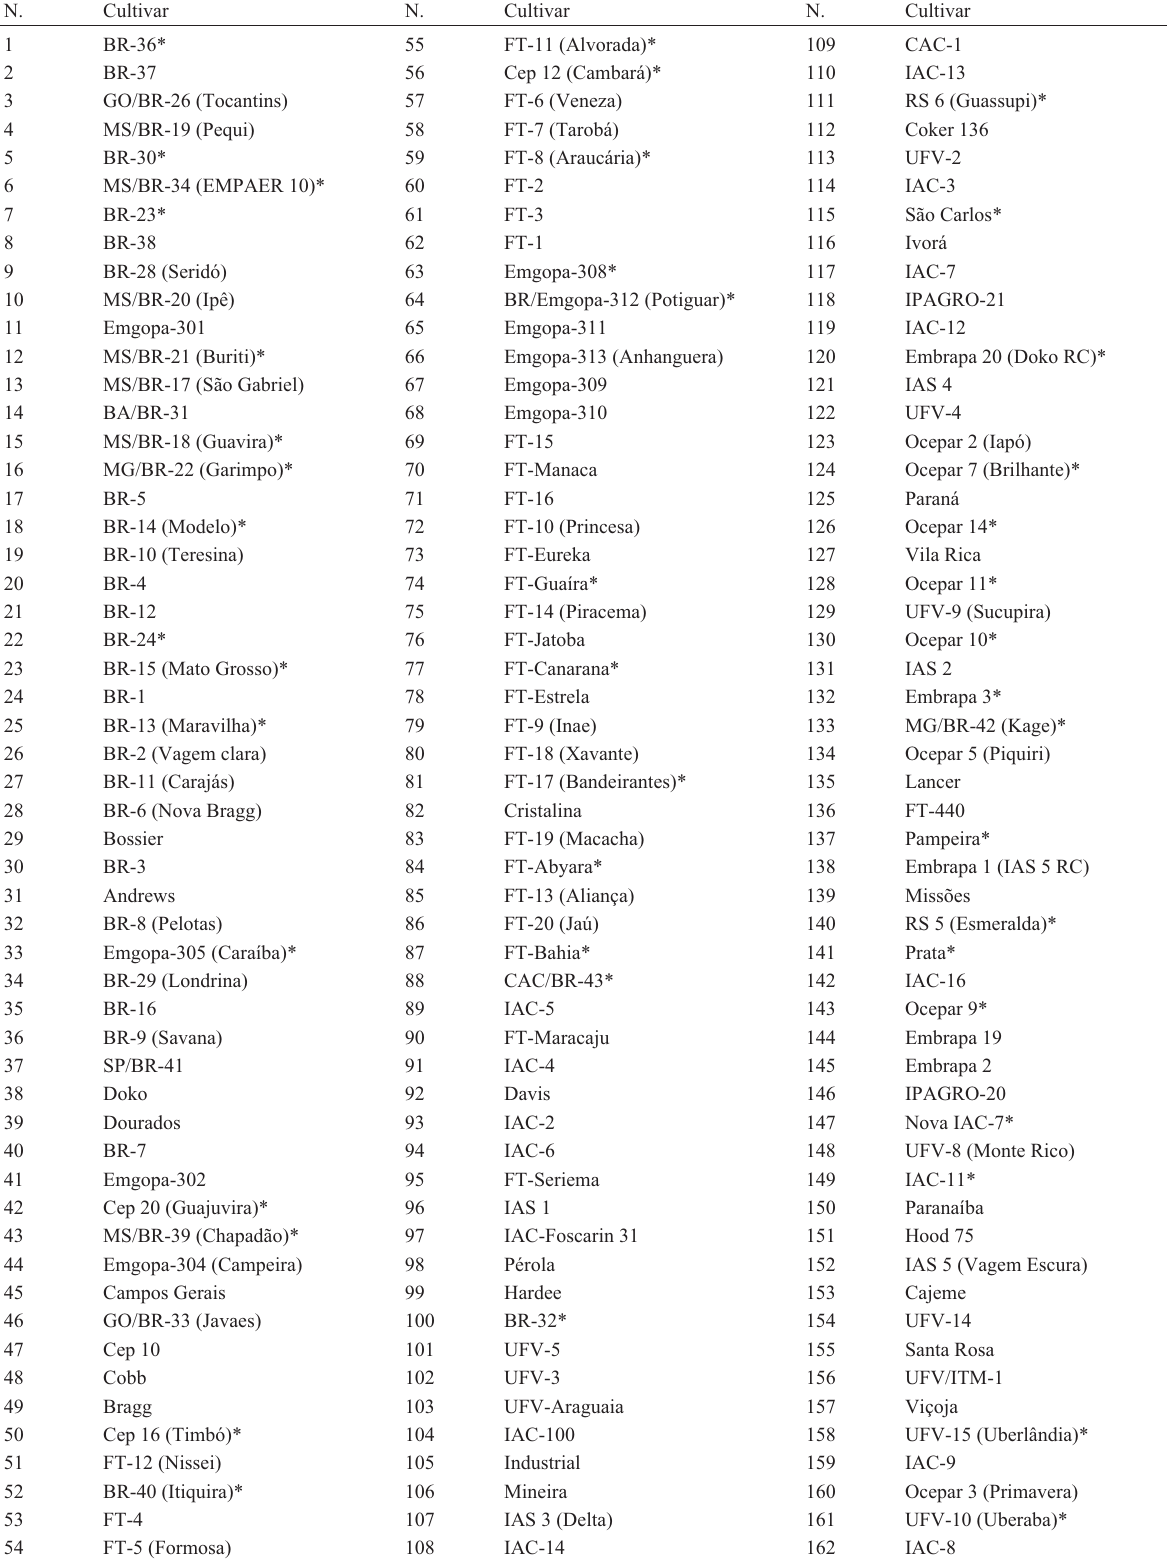
Table 1 - Soybean cultivars released in Brazil from 1962 to 1998 and used for the AFLP analysis. N. Cultivar N. Cultivar